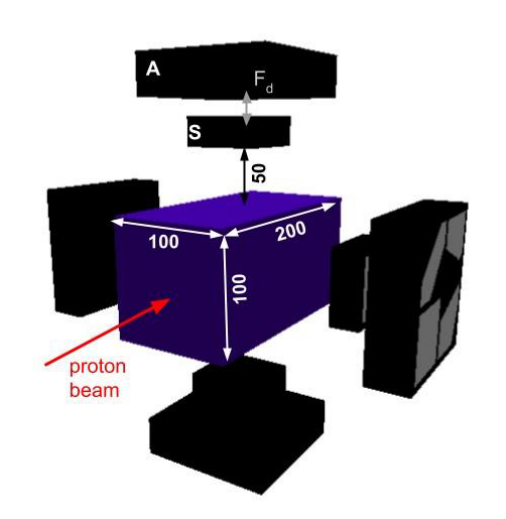
Fig. 4. Simple geometry model implemented in the G EANT 4 code to study the potential application of i-TED/GN-Vision to Prompt Gamma imaging in proton